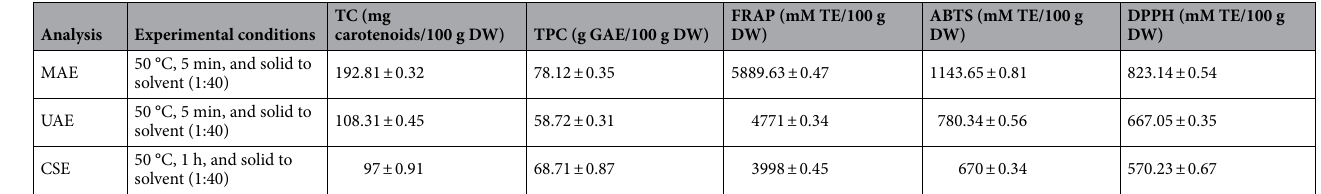
Table 7. Comparison of the extraction yield of TC, TPC, and antioxidants activity (FRAP, ABTS, DPPH) of carrot rejects extracts obtained with MAE, UAE, and